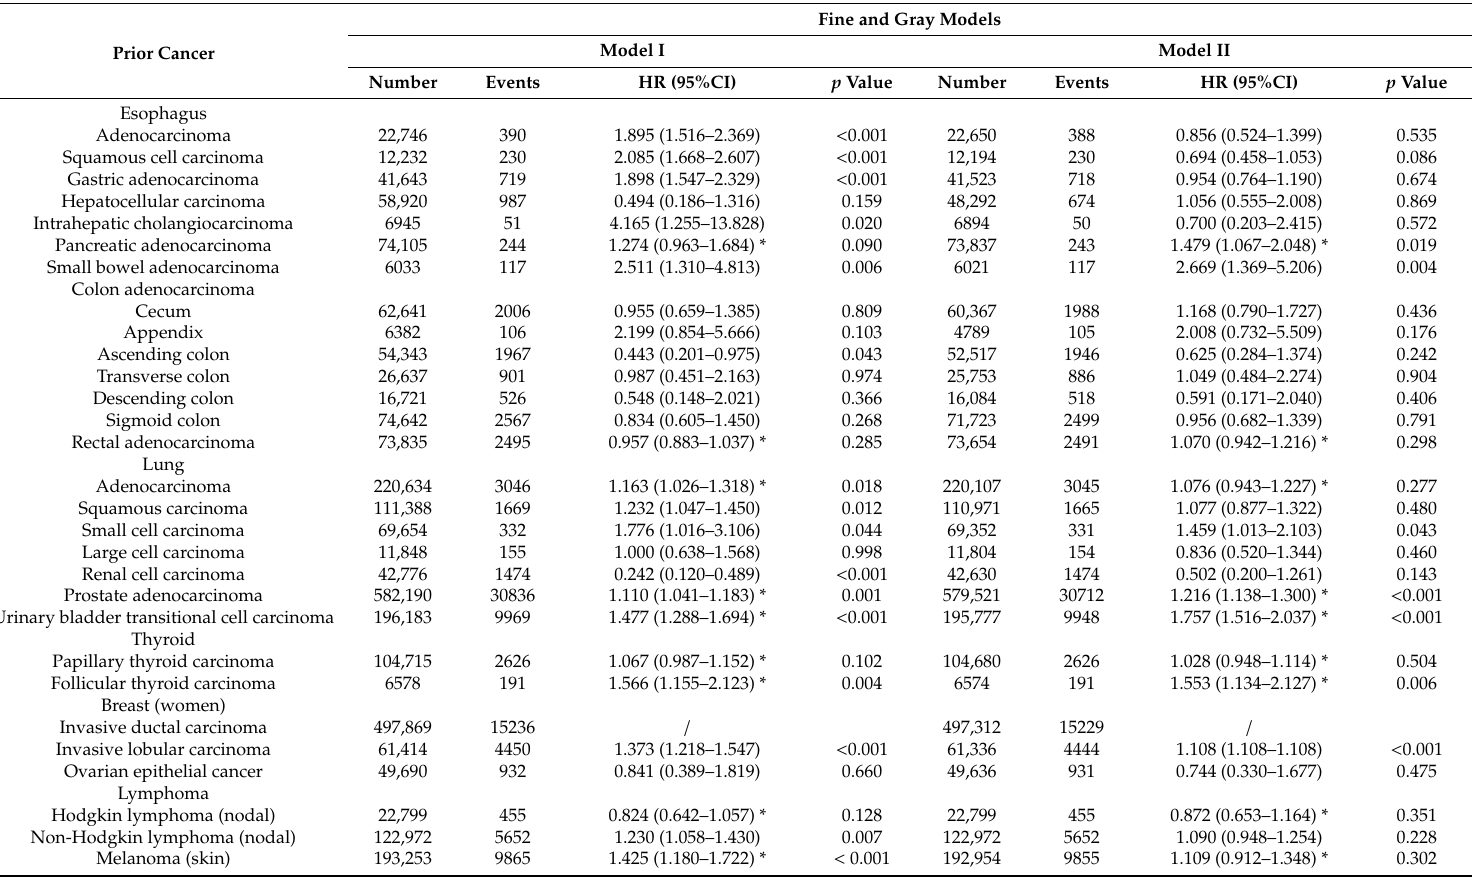
Table 3. The risk for secondary malignancies after radiation in multivariable